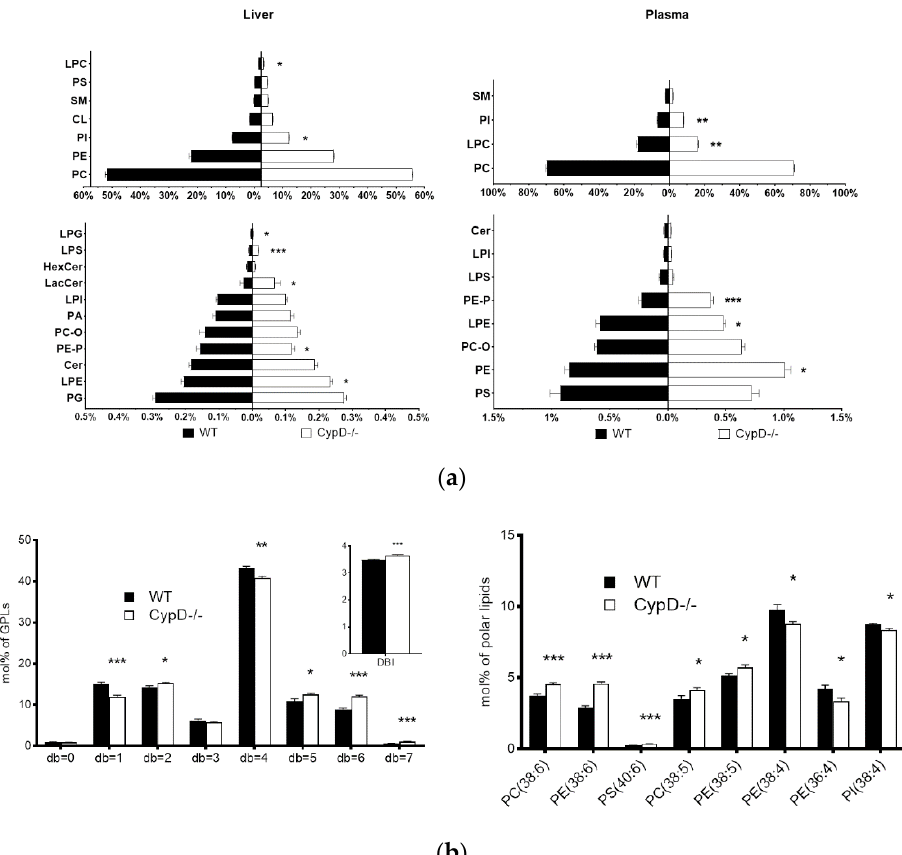
Figure 3. Comparison of the relative lipid content of WT and Cypd-/- samples. Bar charts represent the ( a ) phospholipid composition in liver and plasma samples and ( b ) the double bond number with the calculated DBI in the liver membrane lipidome and the relative concentrations of selected PL species. Data are shown as mean ± SEM, n = 9–11, * p < 0.05, ** p < 0.01, *** p < 0.001. Cer: